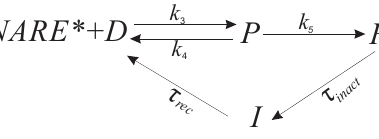
Figure 2. The scheme of SV transitions between